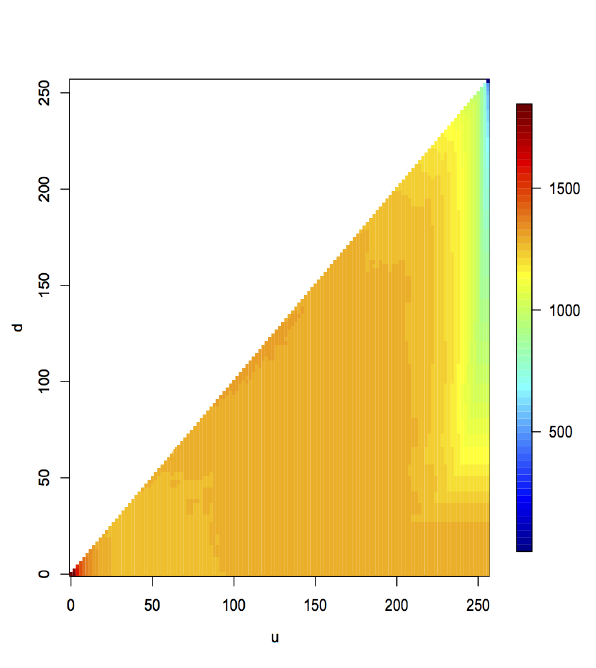
Figure 3: Energy for different values of u and d